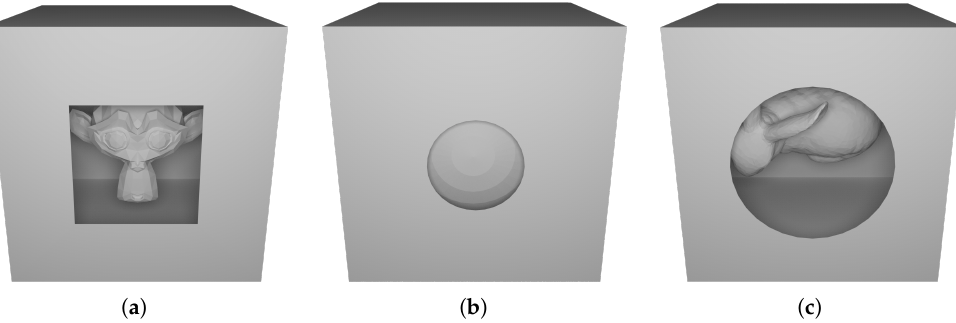
Figure 15. An overview of the 3D models used for numerical tests. ( a ) Sample 1 consists of 986 trian- gles, ( b ) Sample 2 of 1006 triangles and ( c ) Sample 3 of 9297